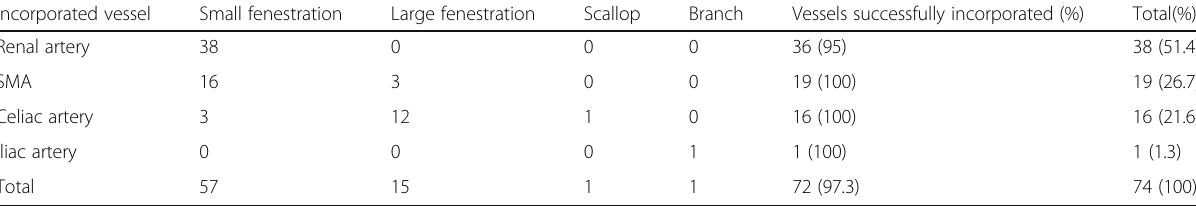
Table 4 Fenestration type, vessels targeted and vessels successfully incorporated Incorporated